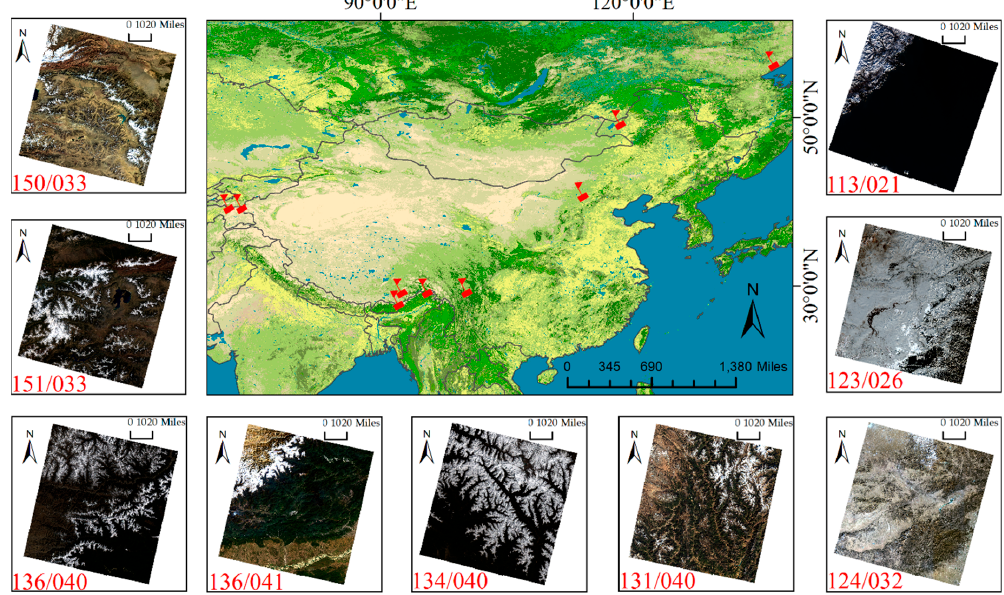
Figure 1. Sites, paths, and rows of the nine Landsat-8 Operational Land Imager (OLI) images.